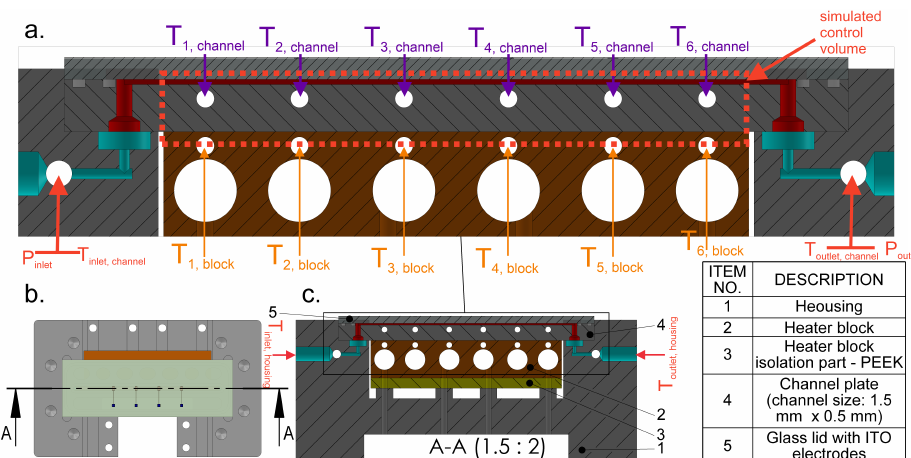
Figure 3. Thermal path with implemented sensors of the boiling liquid in the housing. Light blue is the liquid path inside the housing and red is liquid path inside the channel plate. ( a ). Cropped zoom of the cross section with temperature sensors in the channel plate, heater block, and housing. ( b ). Top view of the housing assembly with heater block, channel plate, and glass lid. ( c ). A-A cross section of the housing